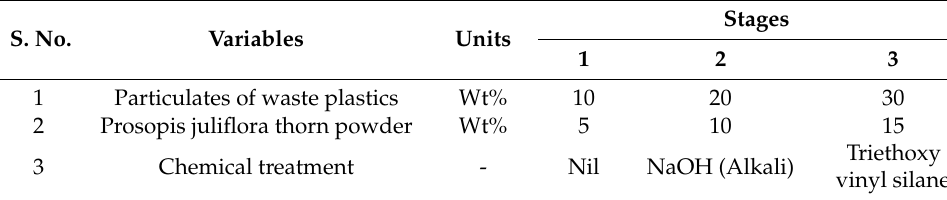
Table 1. Process variables and their various stages.